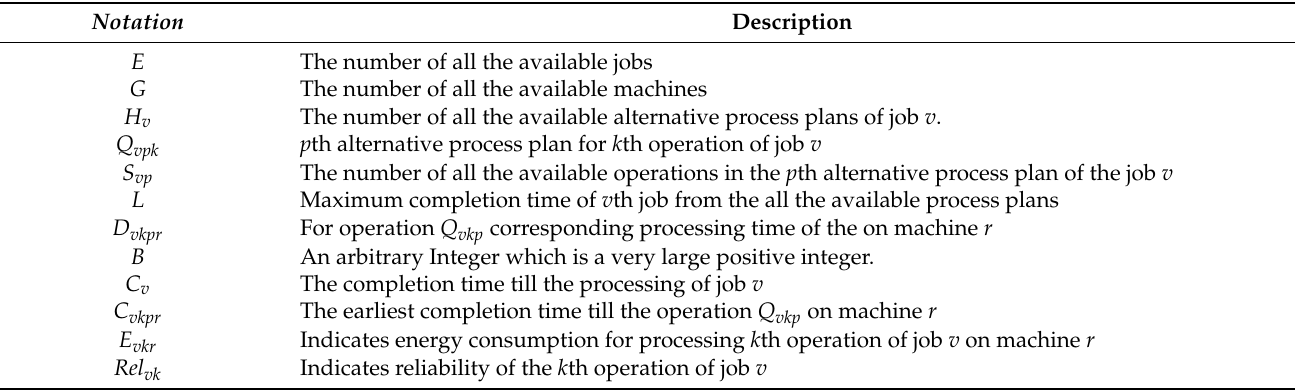
Table 1. Notations used in mathematical